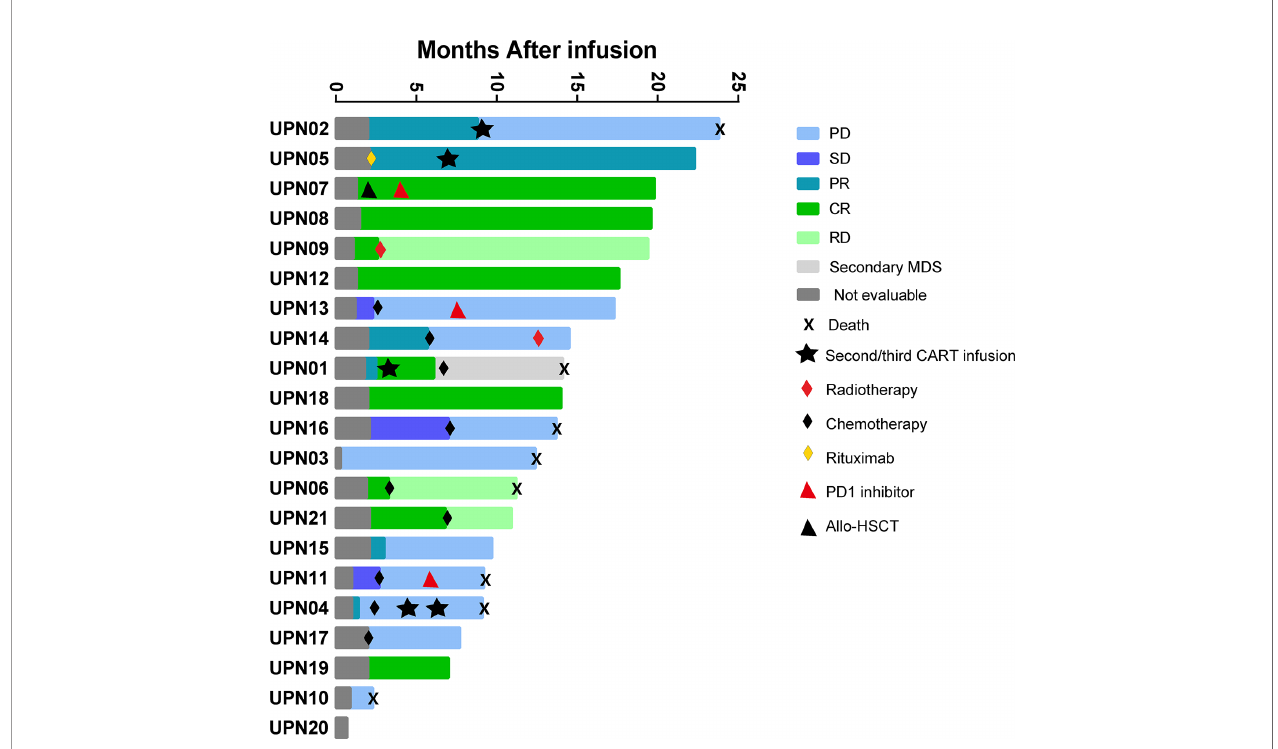
FIGURE 2 | The waterfall plot of individual response. Allo-HSCT, allogeneic hematopoietic stem cell transplantation; CR, complete response; MDS, myelodysplastic syndrome; PD, progressive disease; PR, partial response; RD, relapsed disease; SD, stable